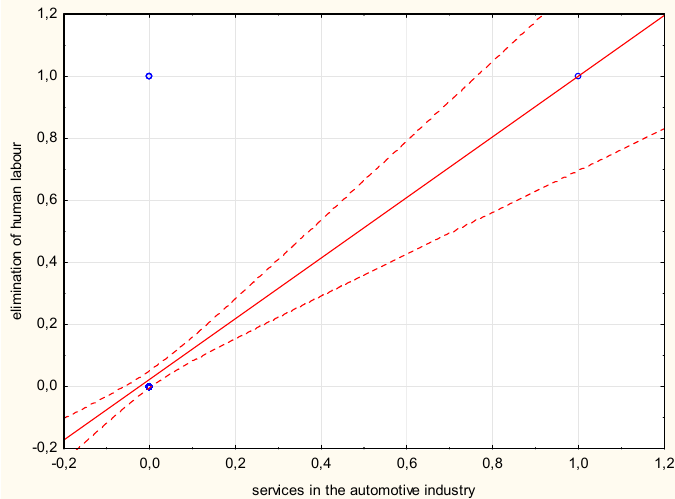
Figure 11. Interactions between the process of providing services in the automotive industry. vis-à- vis the elimination of human labour.